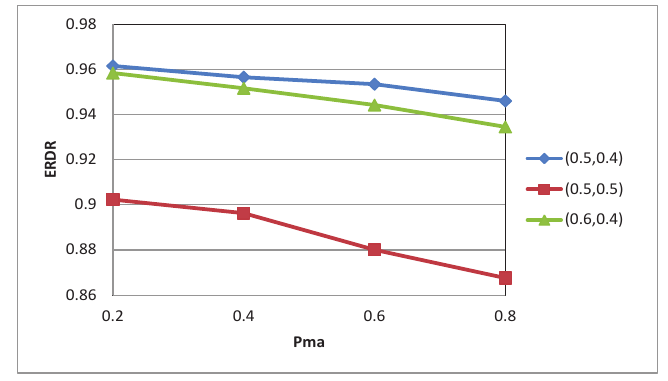
= 2 r , when r . ma e c